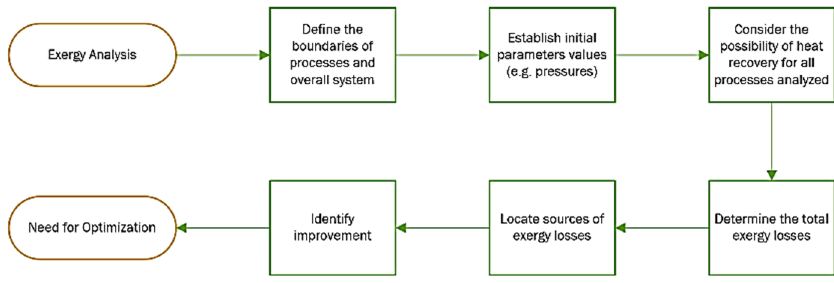
Figure 8. Block diagram of the required steps for conducting exergy analysis.